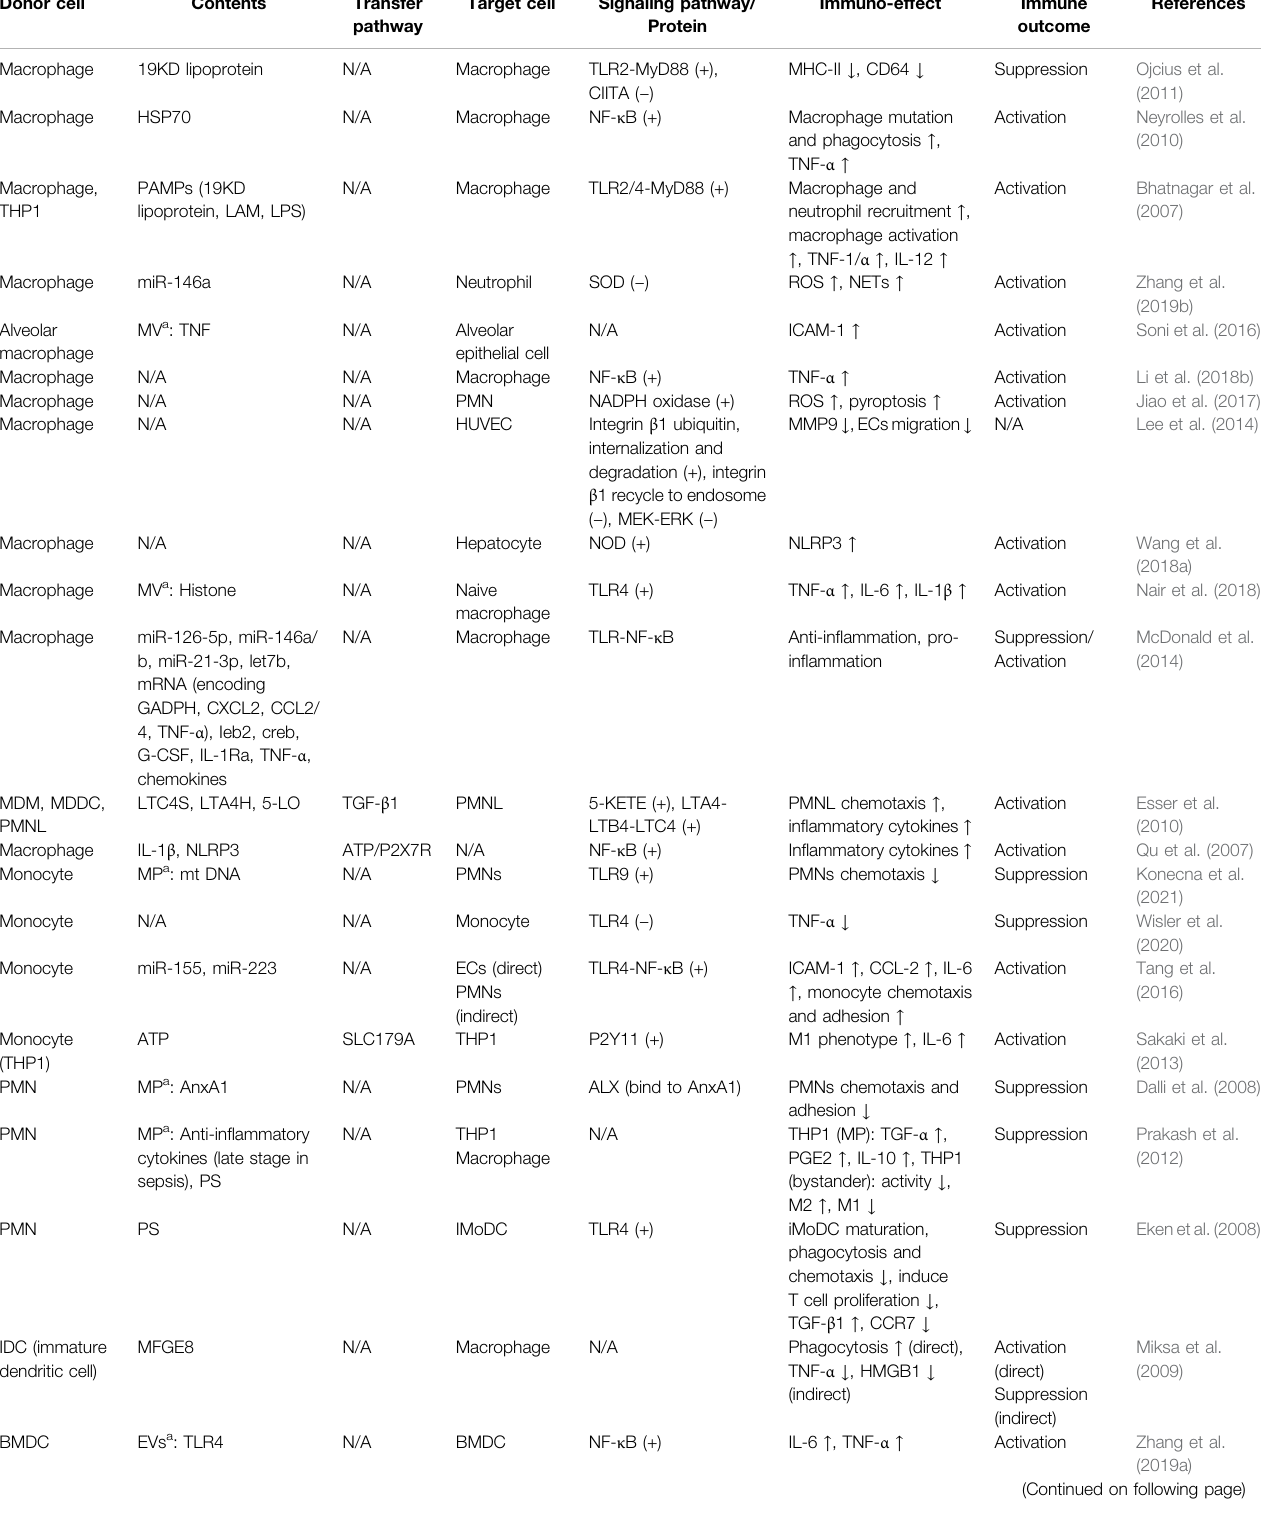
TABLE 2 | Immunomodulatory effect of exosomes derived from immune cells in sepsis. Donor